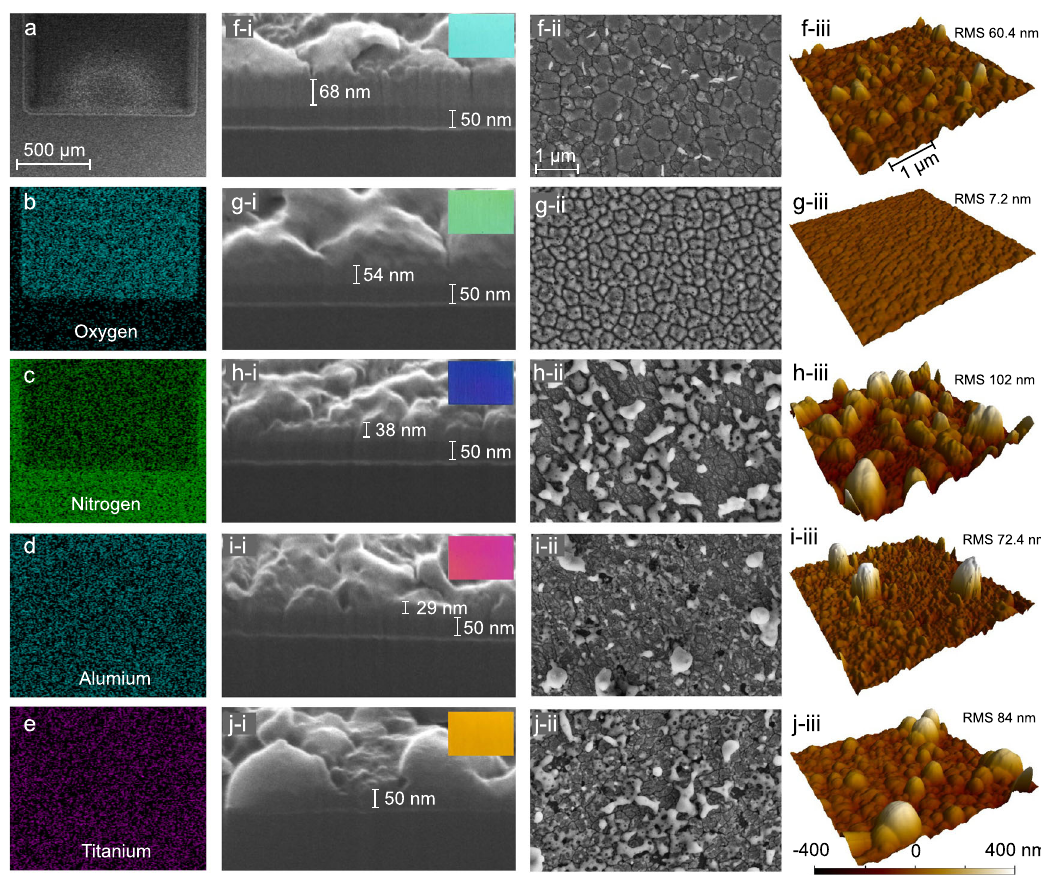
Fig. 4 | Material properties of laser-printed colors. a – e SEM image and corre- sponding EDX maps of a laser-written area with green color. Cross-sectional view images that are obtained by focused ion beam milling [( f – i ) – ( j – i )], high-resolution SEMimages [( f - ii )-( j - ii )]and AFM images[( f-iii )-( j - iii )]of fi ve differentlaser-colored areas(lightbluein f ;greenin g ;bluein h ;redin i ;andyellowin j )thatareobtained